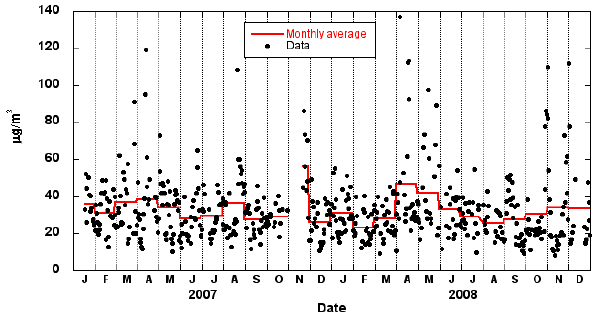
Figure 2. Daily and monthly mean PM 10 concentrations in the years